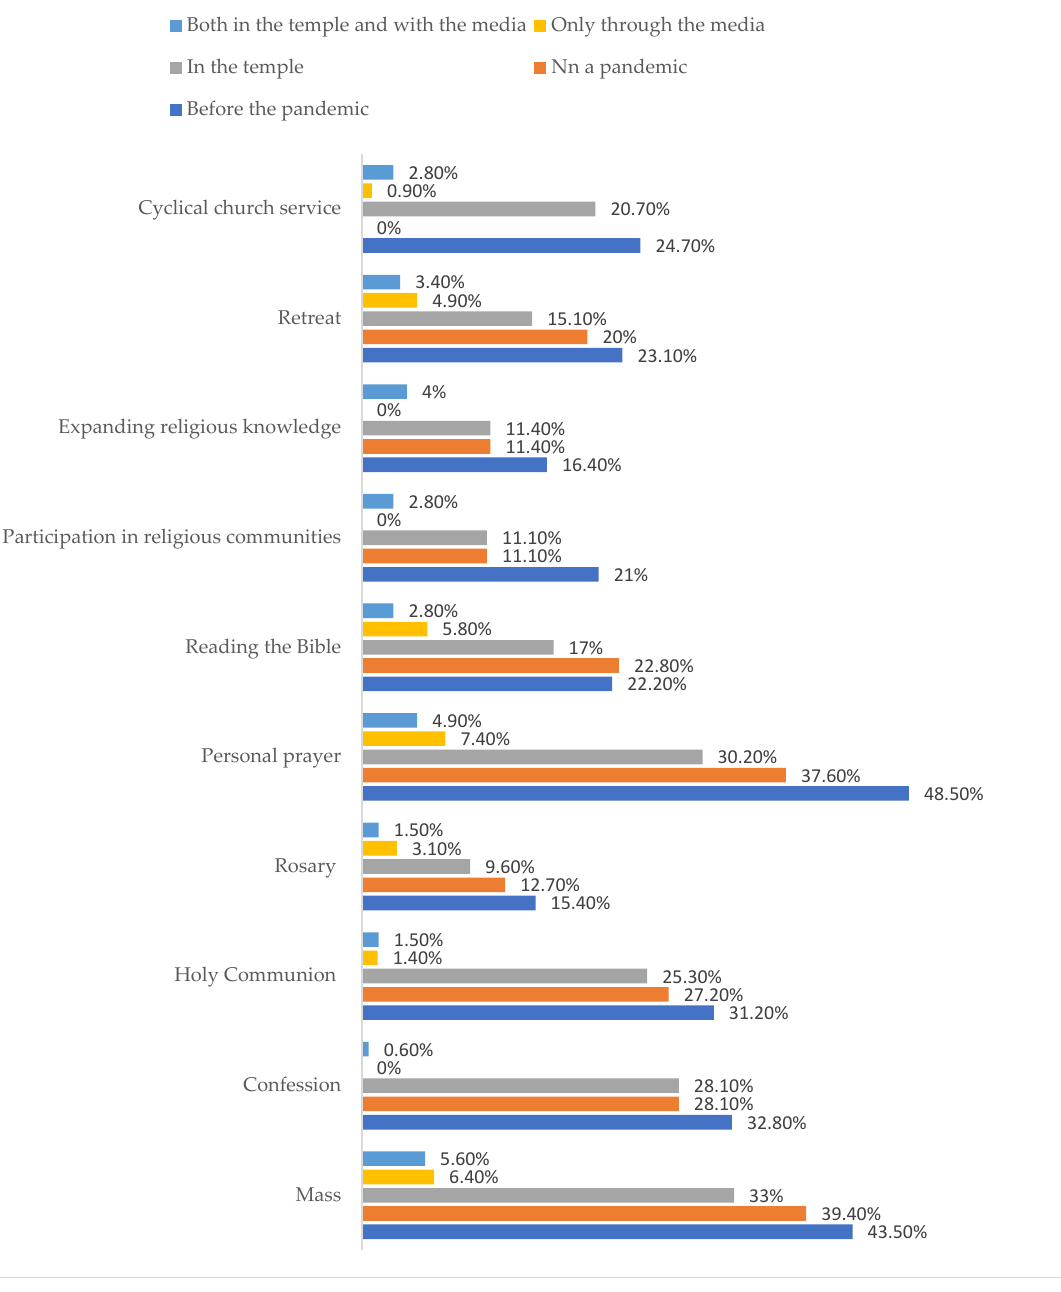
Figure 3. Percentage summary of practitioners before and during the pandemic, as well as modes of practice (in the temple and through media such as TV or radio).